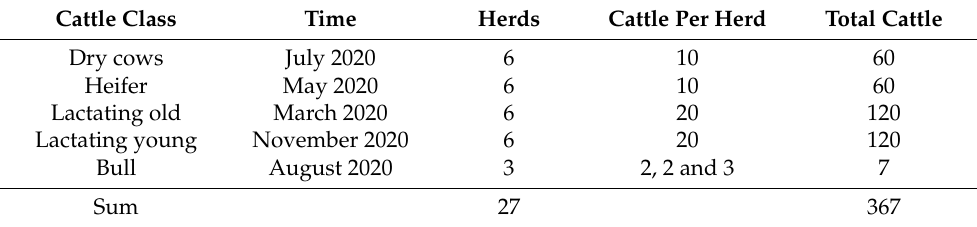
Table 2. The number of herds tested in each cattle class, the number of animals in each herd, and the time when testing was undertaken. Lactating old = lactating cow with old calves, Lactating young = lactating cows with young calves. Cattle Class Time Herds Cattle Per Herd Total Cattle